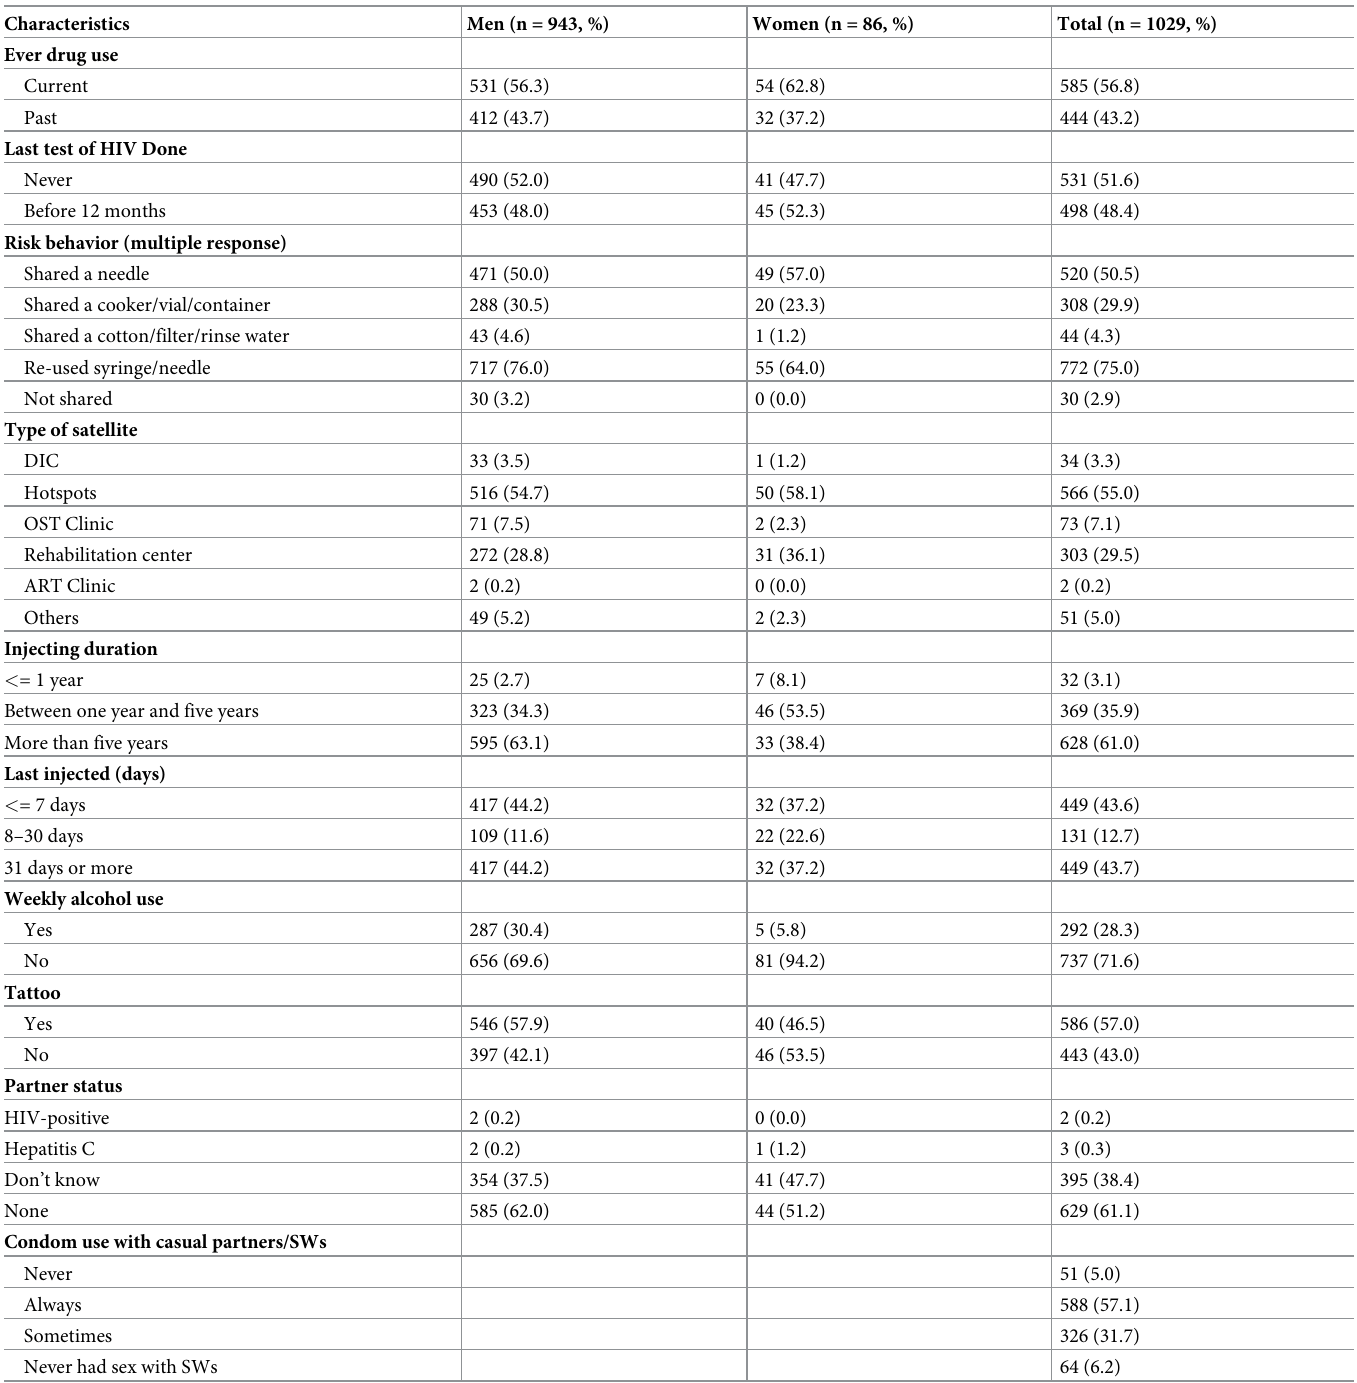
Table 2. Risk characteristics of participants by gender.